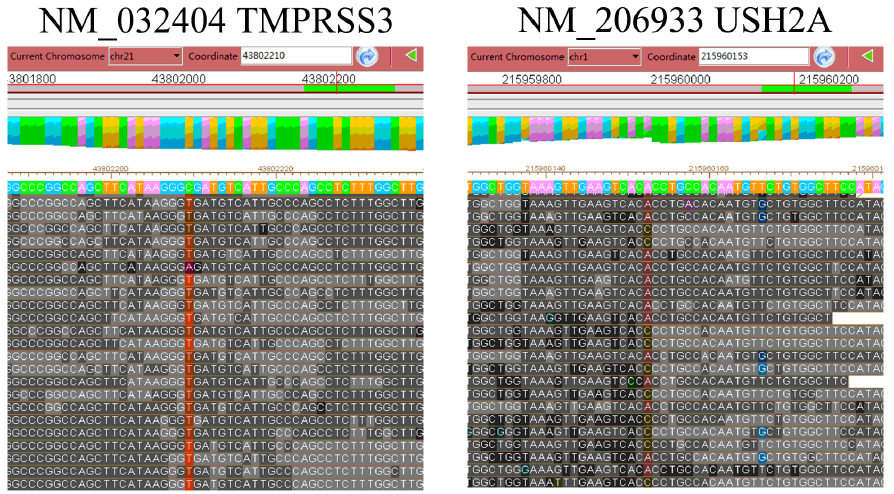
Figure 2. Deep sequencing data for the homozygous mutation in TMPRSS3 and the heterozygous mutation in USH2A . Sequencing alignment data for the homozygous mutation TMPRSS3: c.535G . A is shown in the left panel. Sequencing alignment data for the heterozygous mutation USH2A: c.10246 T . G is shown in the right